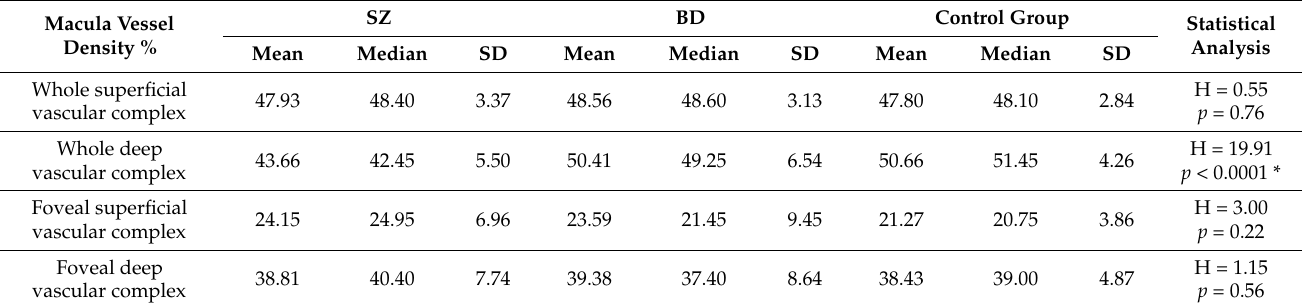
Table 3. Vessel density in the macular superficial and deep vascular complexes in two areas (whole 6 × 6 mm area and in the fovea) in the SZ and BD patients and the control group.